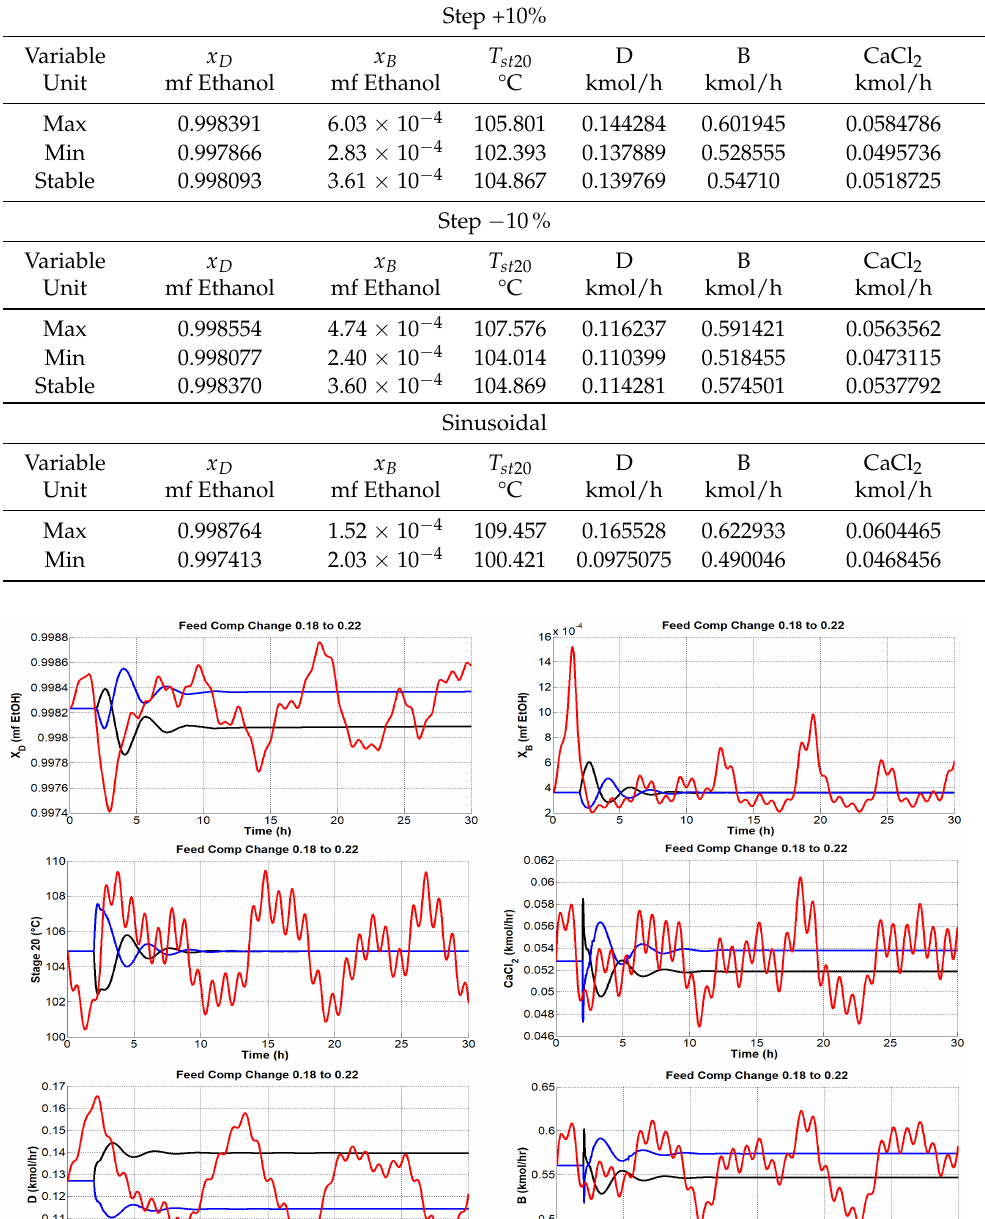
Table 8. The behavior of the process using structure D. Maximum, minimum, and stabilization values in the event of disturbances in the feed composition.